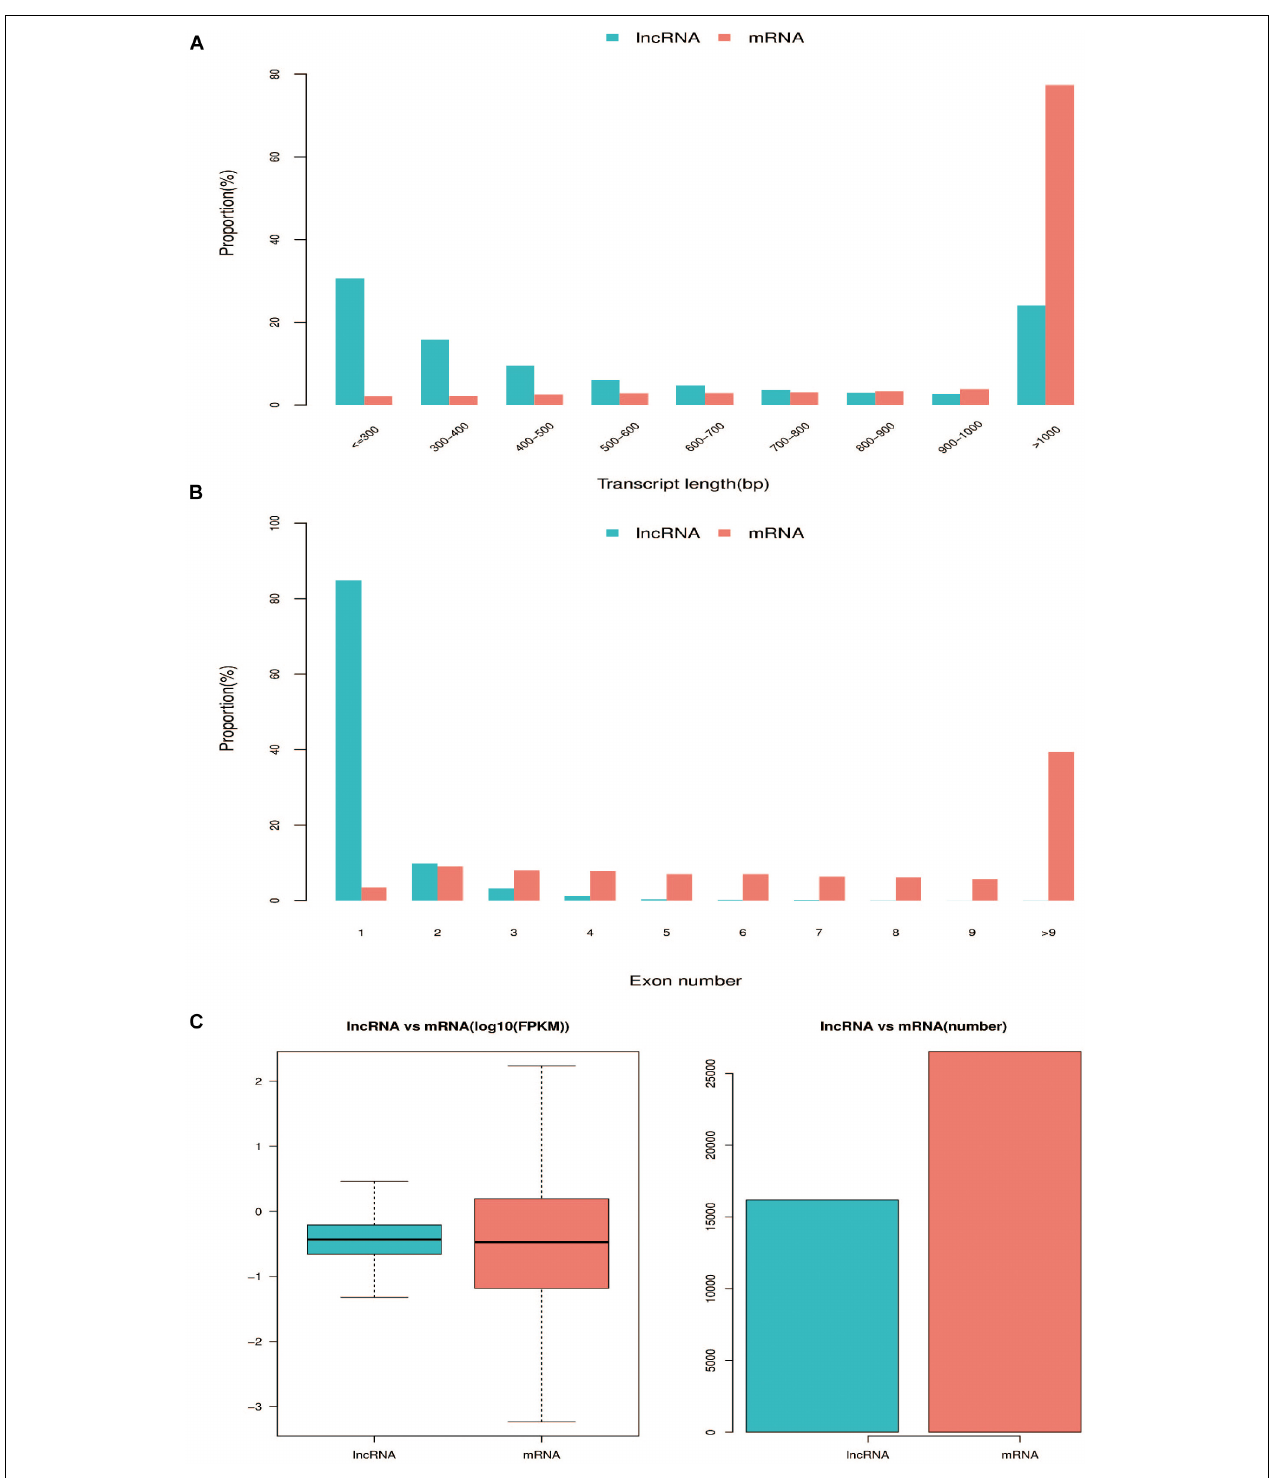
FIGURE 1 | Comparison of genomic features between predicted lncRNAs and mRNAs. (A) Distribution of transcript lengths in lncRNAs and mRNAs. (B) Distribution of the number of exons in lncRNAs and mRNAs. (C) Expression level of lncRNAs and mRNAs.